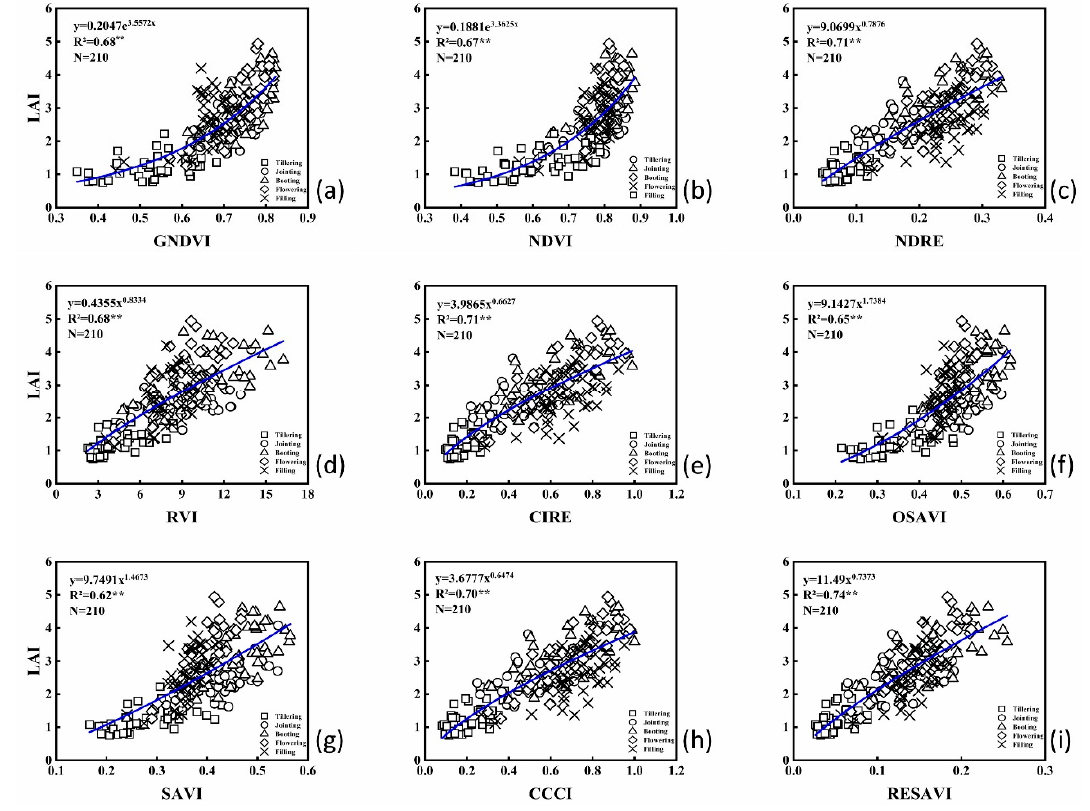
Figure 4. Leaf area index plotted against vegetation indices for the whole growth season of wheat: ( a ) GNDVI; ( b ) NDVI; ( c ) NDRE; ( d ) RVI; ( e ) CIRE; ( f ) OSAVI; ( g ) SAVI; ( h ) CCCI; ( i ) RESAVI.